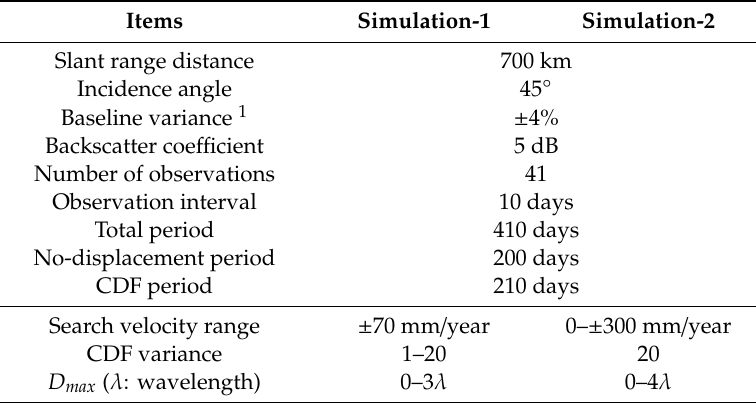
Table 1. The simulation conditions.